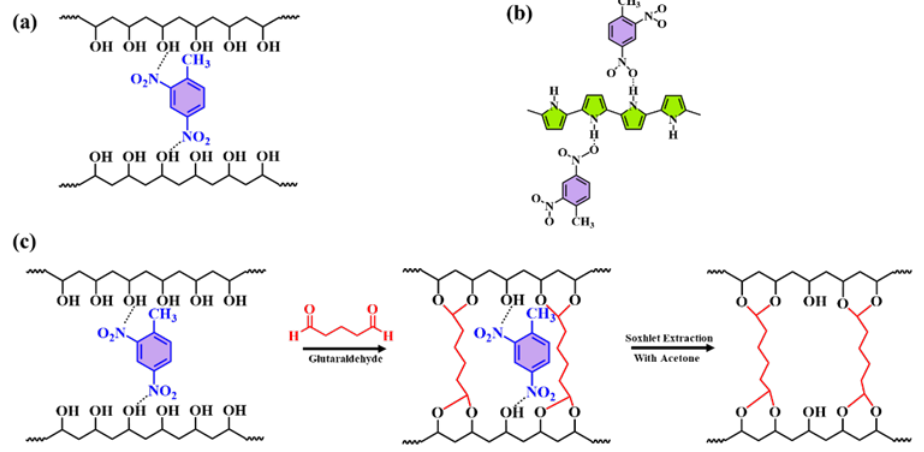
Figure 11. A diagram depicting the interactions of 2,4-DNT with the components of nanocomposite materials ( a ) PVA, ( b ) PPy and ( c ) MIP. Reprinted with permission from [60].